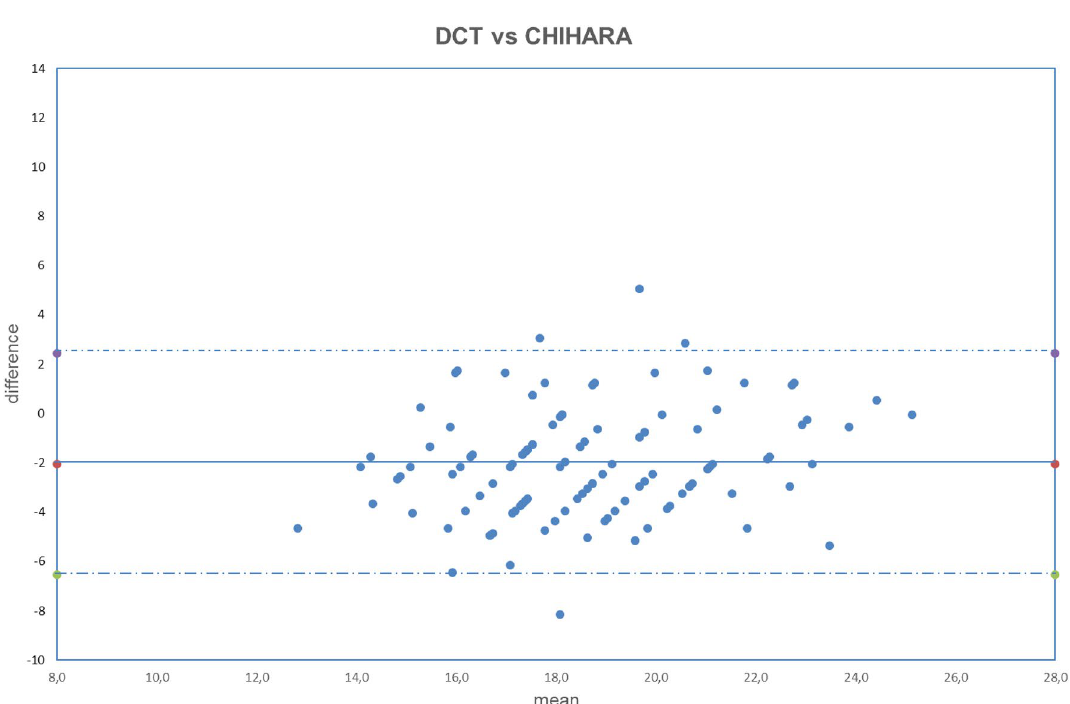
Figure 4. Bland–Altman plot between IOP measured with DCT and GAT corrected with Chihara formula. Dashed line: mean difference. Dash-dotted lines: mean difference (− 2.04 mmHg) ± 2 standard deviation (2.24 mmHg) of the